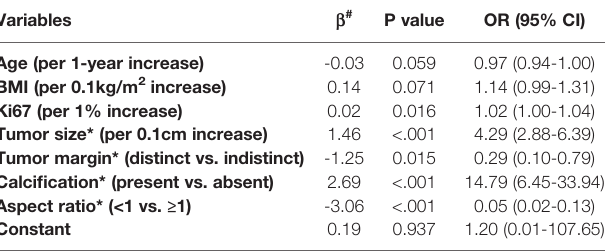
# Unstandardized b coef fi cients were calculated from the multivariate logistic regression analysis based on stepwise regression (AIC: 267.85). *Variables based on US results. CI, con fi dence interval.